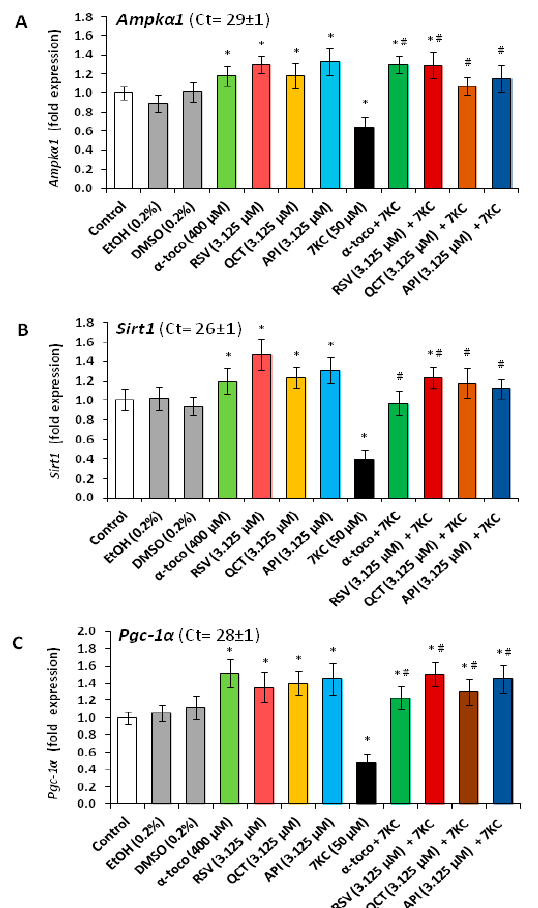
Figure 7. Effect of resveratrol, quercetin, apigenin or α -tocopherol on 7KC-induced mitochondrial biogenesis disorders: measurement of the mRNA levels of Ampk α 1, Sirt1 and Pgc-1 α by real time-quantitative polymerase chain reaction. N2a cells were cultured for 48 h with or without 7-ketocholesterol (7KC, 50 µM) in the presence or absence of α -tocopherol ( α -toco: 400 µM) used as a positive control for cytoprotection, or with polyphenols: resveratrol (RSV), quercetine (QCT) or apigenin (API) used at a concentration of 3.125 µ M. The relative expression of Ampk α 1 ( A ), Sirt1 ( B ), and Pgc-1 α ( C ) mRNAs was determined by